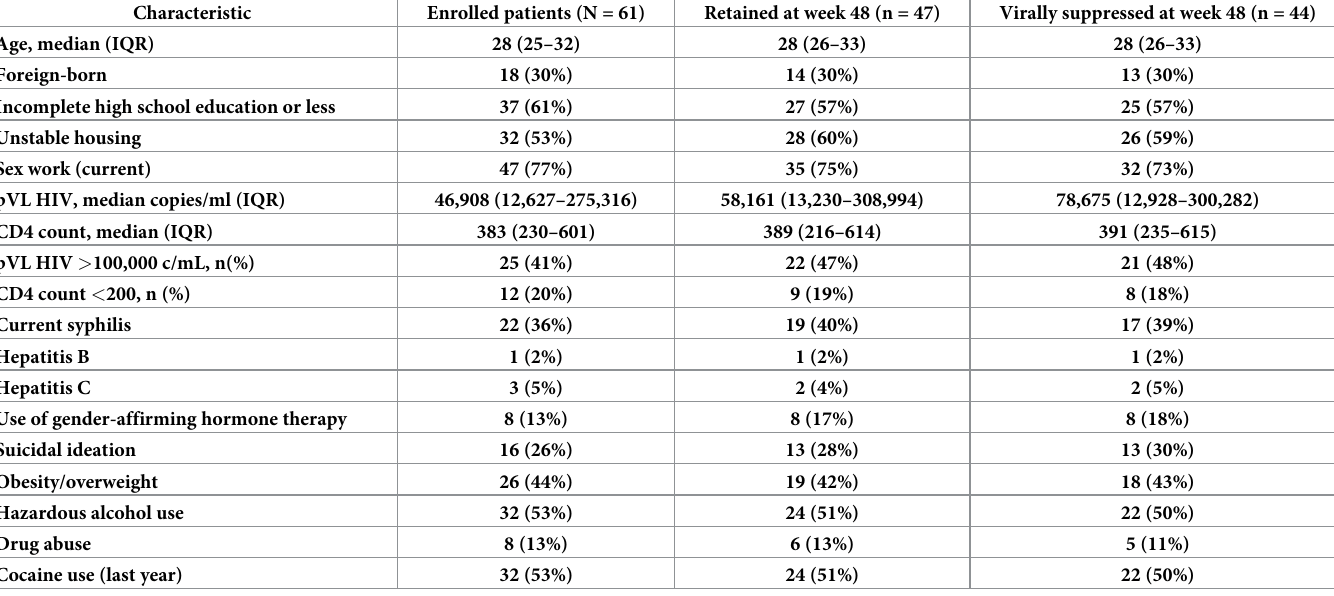
Table 2. Baseline characteristics of enrolled, retained, and virally suppressed HIV positive